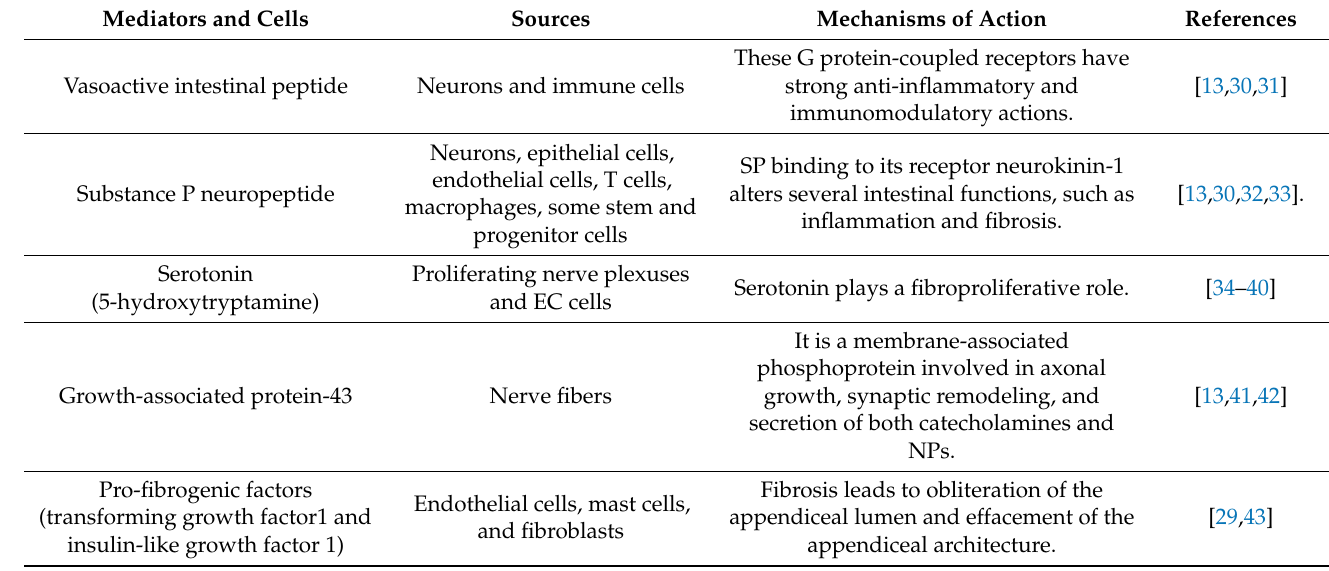
Table 1. Mediators and cells involved in the generation of the neuroinflammatory response in neurogenic